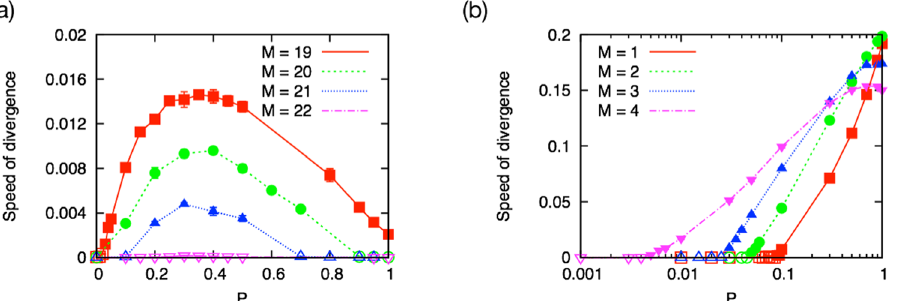
Figure 5. The growth behavior of the partially bidirectional systems in ( a ) the dense interaction regime and ( b ) the sparse interaction regime. ( a ) Moderate proportion of bidirectional links brings the system from the finite phase to the diverging phase. The speed of divergence is asymmetric as a function of the bidirectionality and there exists an optimum bidirectionality for the growth rate at around P ~ 1/3. ( b ) The speed of divergence increases monotonically from zero as a function of proportion of the bidirectional links. A small but finite bidirectionality brings the sparsely connected system from the finite phase to the diverging